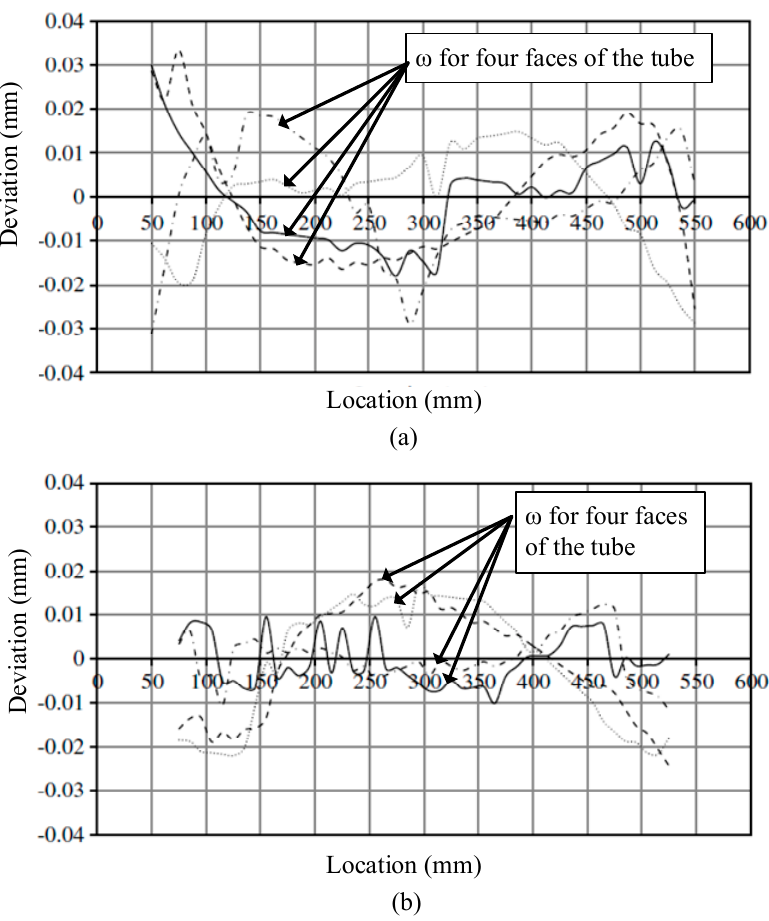
Figure 5. Distribution of ω in the longitudinal direction for two tubes reported in the work of [19]. ( a ) RHS 100 × 40 × 2; ( b ) SHS 60 × 60 × 3.